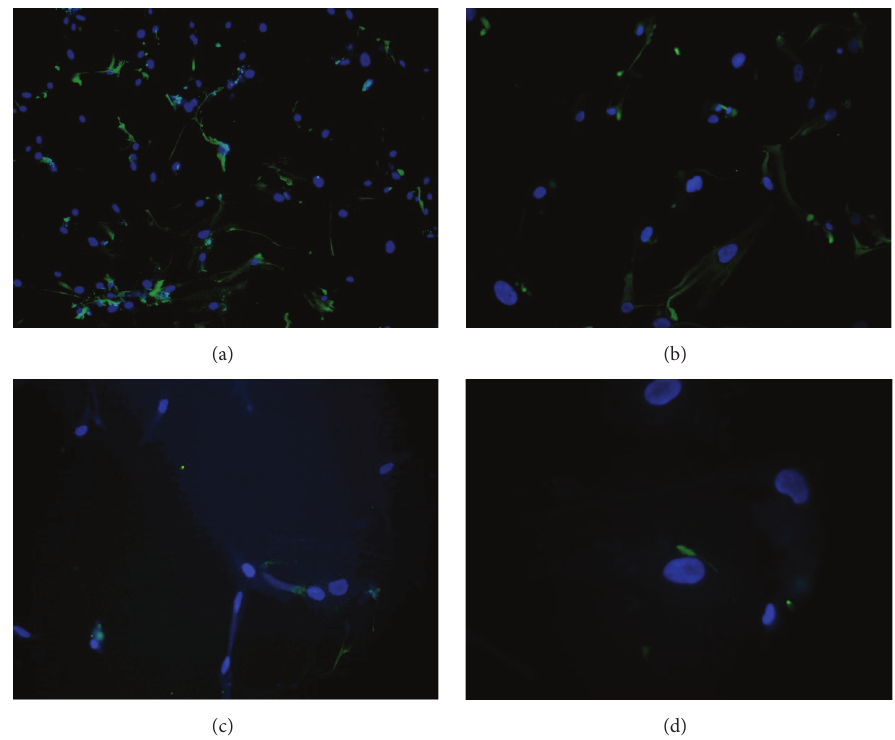
Figure 6: Immunohistochemical analysis of proteins associated with neural lineages in pituitary adenoma cell cultures. (a) HA002, NES (green), 100x magnification; (b) HA006, NES (green), 200x magnification; (c) HA006, A2B5 (green), 200x magnification; (d) HA032, ATXN1 (green), 200x magnification. Nuclei were stained with DAPI (blue). All analysed samples showed great NES expression, mild A2B5 and GFAP staining, and, in several cells, very weak ATXN1 expression. NES, nestin; A2B5 binds to neural tissue such as brain, spinal cord, and dorsal root ganglia; GFAP, glial fibrillary acidic protein; ATXN1, ataxin